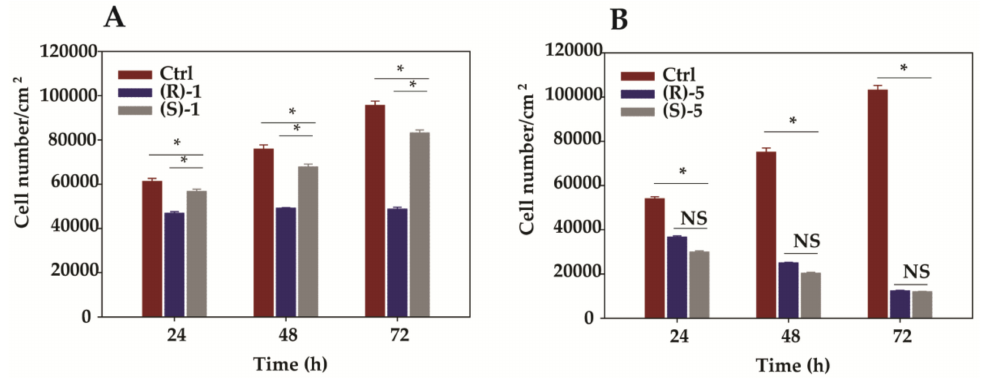
Figure 4. E ff ects on cell proliferation. ( A ) Antiproliferative e ff ect of ( R ) - 1 and ( S ) - 1 on HT29 at 24, 48, and 72 h of treatment as compared with the control. ( B ) Antiproliferative e ff ect of ( R ) - 5 or ( S ) - 5 in the same experimental conditions. The analysis was carried out by two-way analysis of variance (ANOVA) followed by the Bonferroni multiple comparisons. The di ff erences of at least p < 0.05 were considered significant. Statistical analysis was carried out using Prism GraphPad